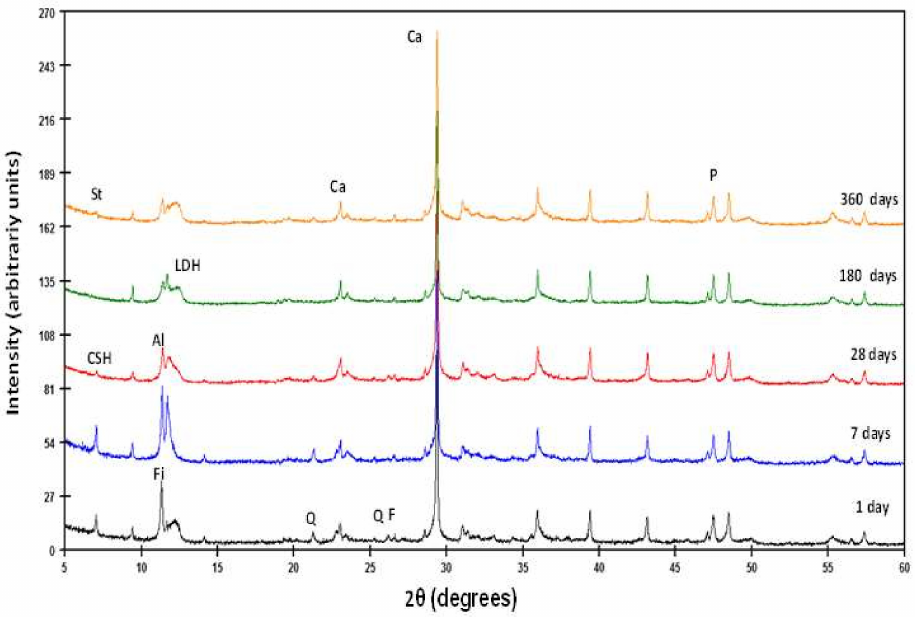
Figure 5. XRD patterns of solid phases from waste / lime system. Q—quartz; F—feldspars; Fi—phyllosilicates; Layered Double Hydroxides (LDH) compounds; Al—aluminate; St—stratlingite; Ca—calcite; P—portlandite. Table 3. Quantification Rieltveld of the solids phases from waste / lime system (R B and X 2 ,